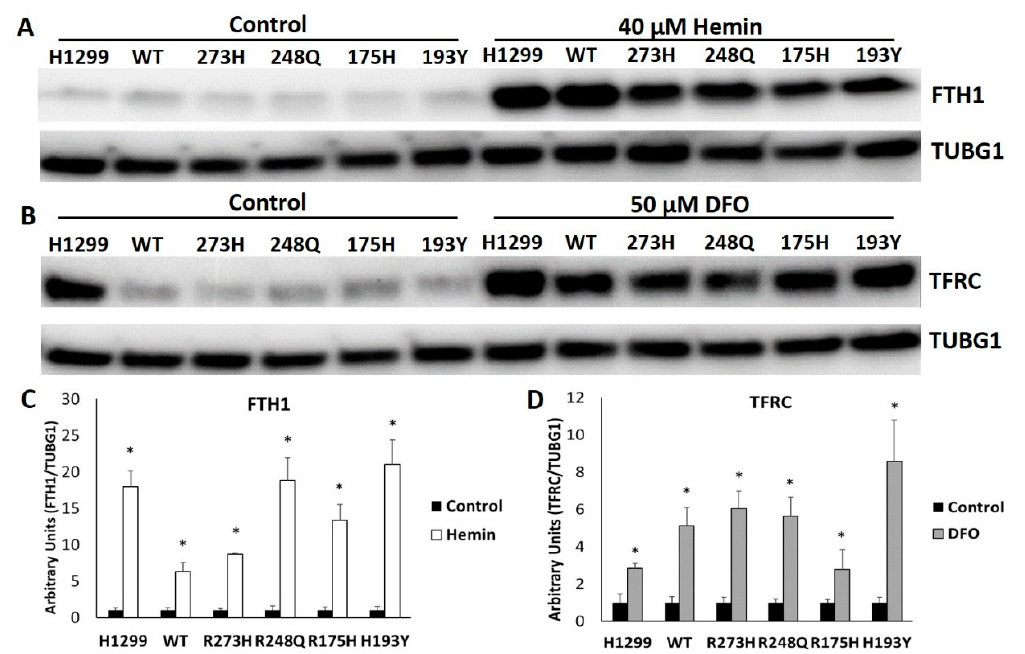
Figure 7. Iron-dependent changes in FTH1 and TFRC protein expression in mutant TP53 expressing cells. Representative Western blot of FTH1 expression following treatment with 50 µ M hemin ( A ) and TFRC expression following treatment with 40 µ M DFO ( B ) protein expression in TP53 null H1299 cells (H1299) or following the induction of the indicated TP53 subtype ( A ). Relative expression levels were quantitated following normalization to TUBG1 as the loading control ( C , D ). * Denotes statistical difference from respective controls, p < 0.05.